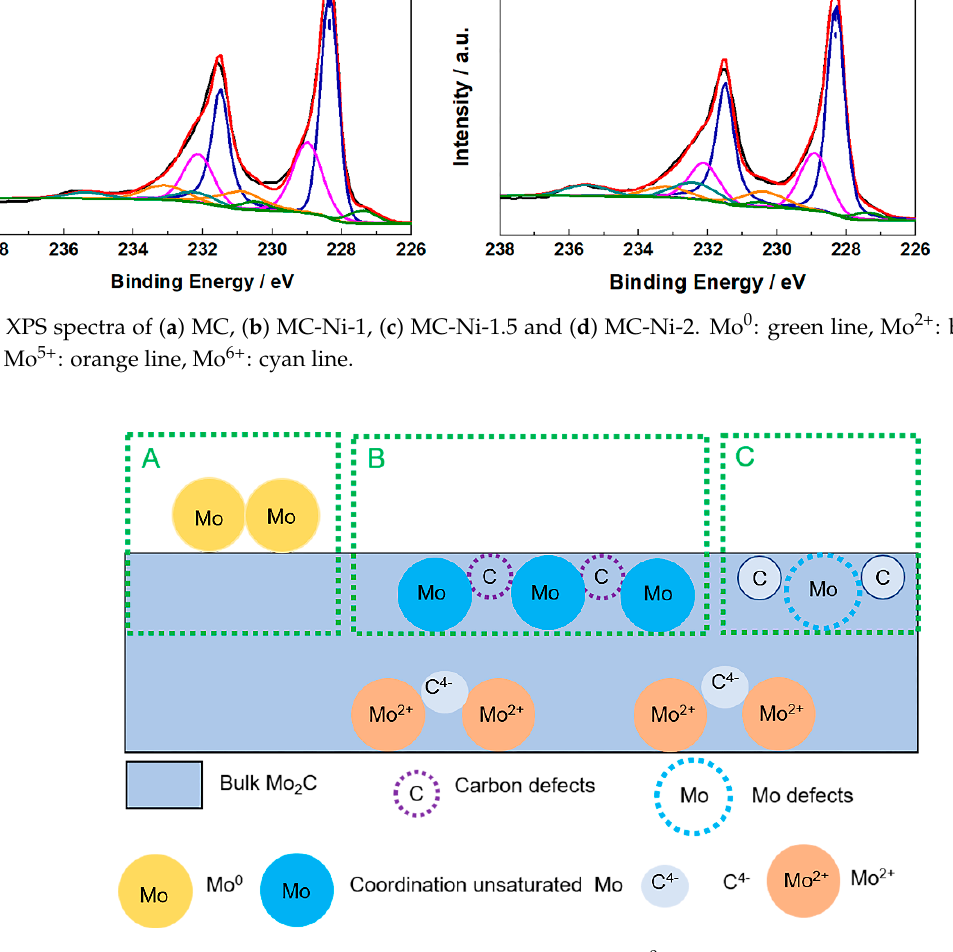
Figure 5. Schematic diagram of Mo 2 C surface. ( A ) Mo 0 , ( B ) carbon defects and ( C ) Mo